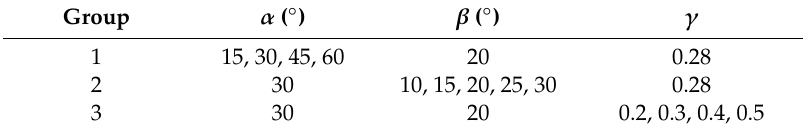
Table 1. Structural parameters of the Venturi model for computational fluid dynamics (CFD) analysis.